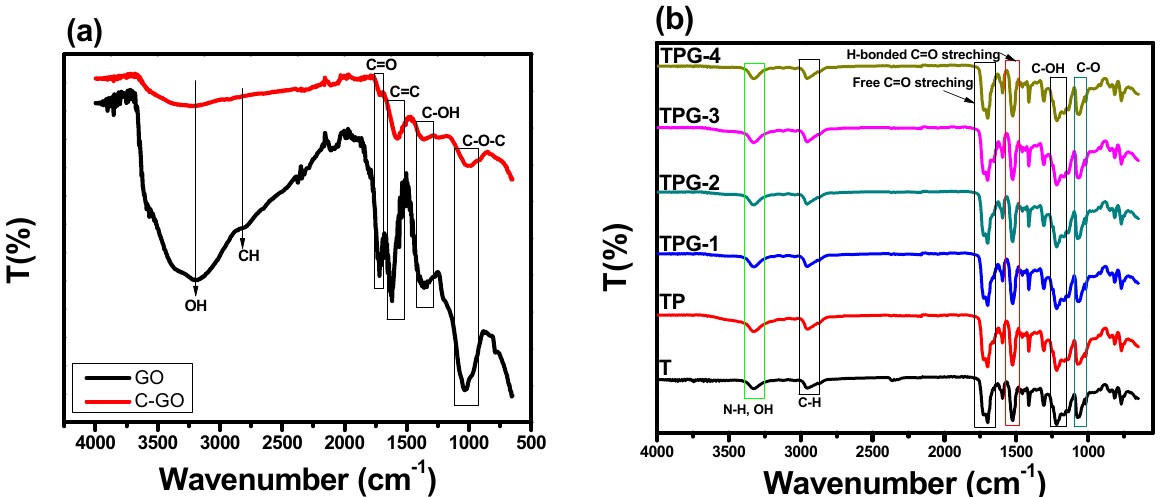
Figure 2. FTIR spectra of ( a ) GO and c-GO, ( b ) pristine TPU and c-GO embedded TPU membranes. Figure 2b represents the FTIR spectra of thermoplastic polyurethane membrane, PVP- based TPU membranes, and TPU membrane with different concentrations of carboxylated graphene oxide. The FTIR spectra of TPU exhibit a transmittance peak at 3330 cm − 1 corresponds to the –NH gorup. The peak positioned at 2960 cm − 1 is ascribed to the CH 2 . Another peak at 1215 cm − 1 is representative of the C-N-H bonding. The functional groups of C-O-C in TPU exhibits peak at 1120 cm − 1 . The spectrum of TPU-PVP shows absorption bands at 1639 cm − 1 and 1215 cm − 1 which denote carbonyl and amide groups. Carboxylated graphene oxide-based TPU membranes exhibit peaks at 3330 cm − 1 , 2960 cm − 1 , 1687 cm − 1 , 1516 cm − 1 , 1215 cm − 1 , and 1120 cm − 1 . All these peaks are present in the